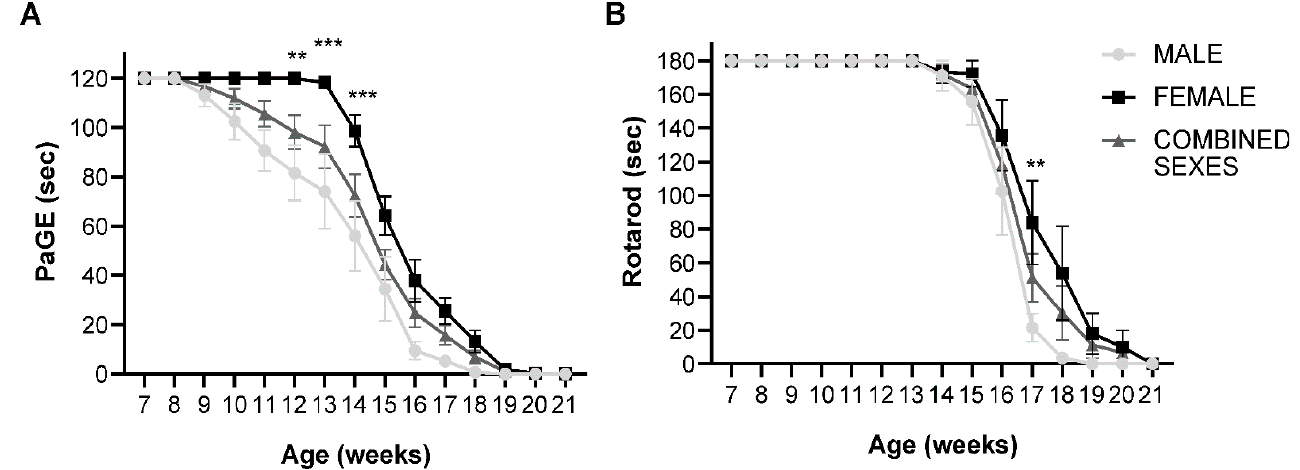
Figure 1. PaGE and rotarod test of untreated male, female and combined sexes: ( A ) PaGE test showing grip endurance of untreated SOD1(G93A) animals. There was a significant difference between male and female untreated groups at week 12 ( p = 0.0038), week 13 ( p = 0.0003) and week 14 ( p = 0.0006), where the female animals displayed significantly better performance compared to the male mice (n = 10 male, 10 female); ( B ) Rotarod test showing motor coordination of untreated SOD1(G93A) animals. A significant difference between male and female mice was observed, with the female untreated mice showing significantly better performance at week 17 ( p = 0.0025) compared to male animals. Results were analyzed by two-way ANOVA followed by the Bonferroni multiple comparisons test. ** p < 0.005; *** p < 0.0005. Data in all graphs are expressed as mean ± SEM.